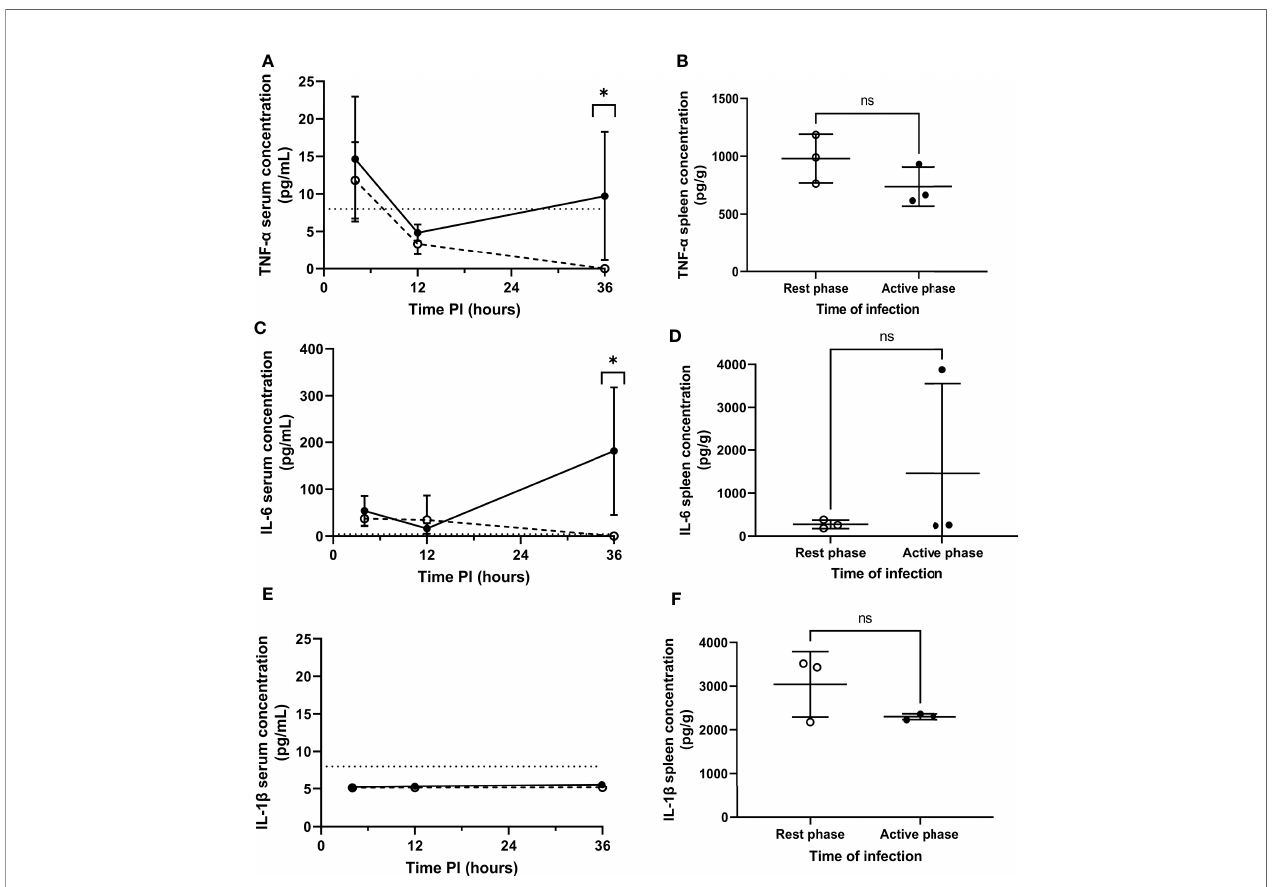
FIGURE 3 | Serum and splenic cytokine concentrations of TNF- a , IL-6 and IL-1 b in rest and active phase-infected mice. Serum and spleen homogenates were retrieved from CD1 mice (n=18) at 4h (spleens+serum), 12h (serum) and 36h (serum) PI. Samples were analysed for TNF- a (A, B) , IL-6 (C, D) and IL-1 b (E, F) concentrations. Rest and active phase-infected mice are represented by open and fi lled circles respectively. Limit of detection is represented by the dotted line. Statistical difference was determined using Mann-Whitney test between both groups of mice at each time point (ns, P>0.05; *P ≤